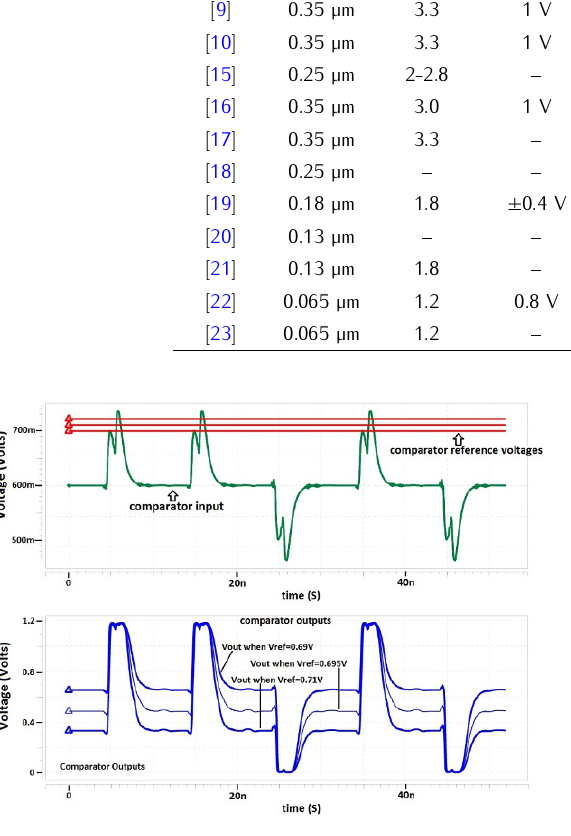
Figure 11. Localization of optimum reference voltage with finer volt- age increments.